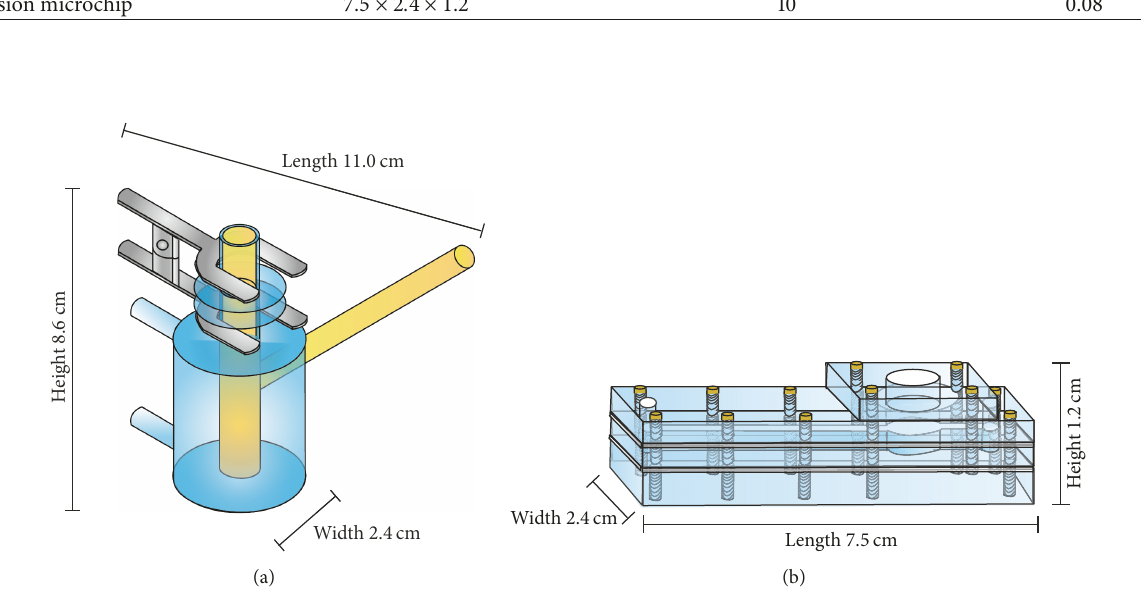
Figure 4: Device size of (a) Franz diffusion cell; (b) diffusion